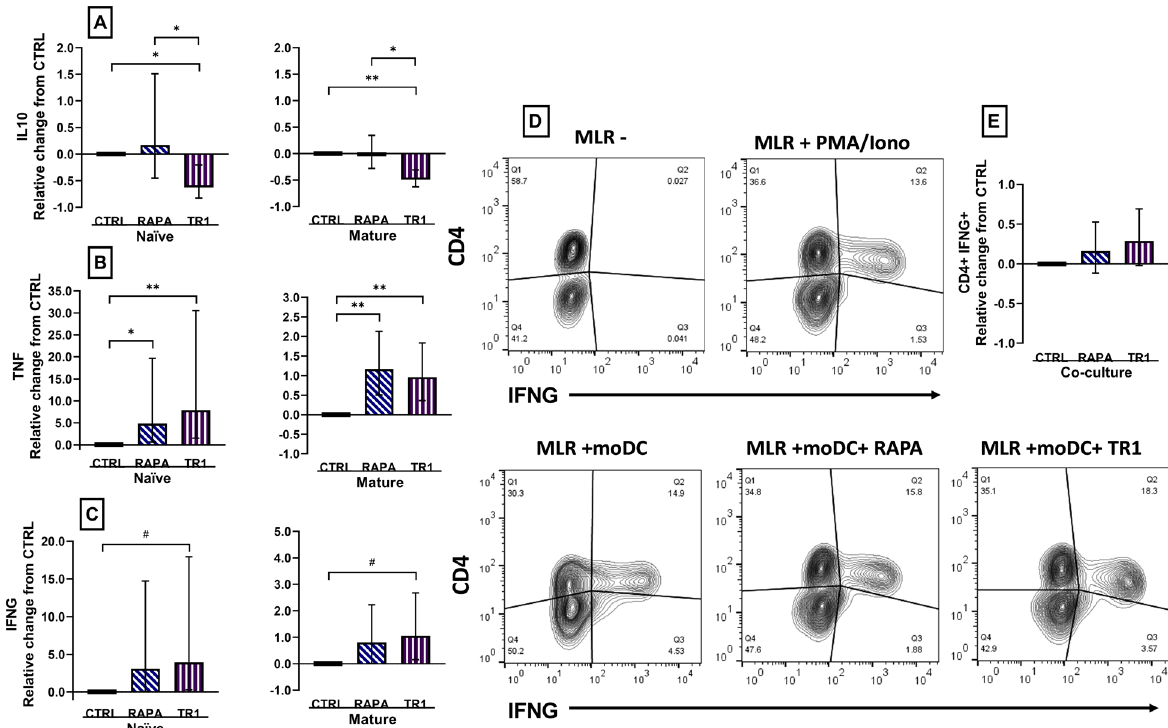
Figure 6. Changes in cytokine concentration of IL10 ( A ), TNF ( B ), and IFNG ( C ) measured in supernatants from moDC that were concurrently treated with vehicle (CTRL), or inhibitors rapamycin (RAPA) or Torin-1 (TR1) at 100 nM during the last 4 days of differentiation before maturation with E. coli (Mature), co-cultured with mixed lymphocyte reaction (MLR), and T-cell activated with anti CD3/CD28. Naïve moDC that were not matured with E. coli were co-cultured and activated in parallel (Naïve). ( D ) Intracellular IFNG expression in CD4 + MLR was analyzed via flow cytometry of MLR co-cultured for 1 day with in vitro-generated moDC (7-day differentiation protocol with 20 ng/mL CSF2 and IL4, matured for 1 day with E. coli ) before activation with anti CD3/CD28 and concurrent incubation with brefeldin A for 6 h. Cells were labeled with anti-bovine CD4 FTIC-conjugated antibodies and after fixation and permeabilization with anti-bovine IFNG A647. Contour plots show fluorescence for CD4-FITC and IFNG A647 of MLR negative controls (w/o moDC), positive controls (stimulated with phorbol myristate acetate (PMA) and ionomycin (Iono), and co-cultures of MLR with moDC treated with vehicle, RAPA or Torin-1. ( E ) Mean fluorescence intensity (MFI) of IFNG staining in CD4+ MLR relative to CRTL. Data from cell isolation of 12 cows were expressed relative to CTRL and presented as relative change from CTRL in naïve and mature moDC. Data are presented as geometric mean and backtransformed 95% confidence interval. ANOVA tests between CTRL and inhibitors, and between inhibitors are presented with Bonferroni-adjustment for multiple comparisons: P ≤ 0.10 ( # ), P ≤ 0.05 (*), P ≤ 0.01 (**), P ≤ 0.0001